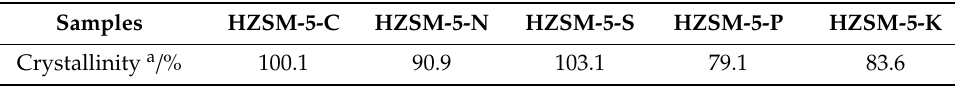
Figure 1. XRD patterns of the synthesized HZSM-5 zeolites. Table 1. Crystallinity of HZSM-5 synthesized with different additives.